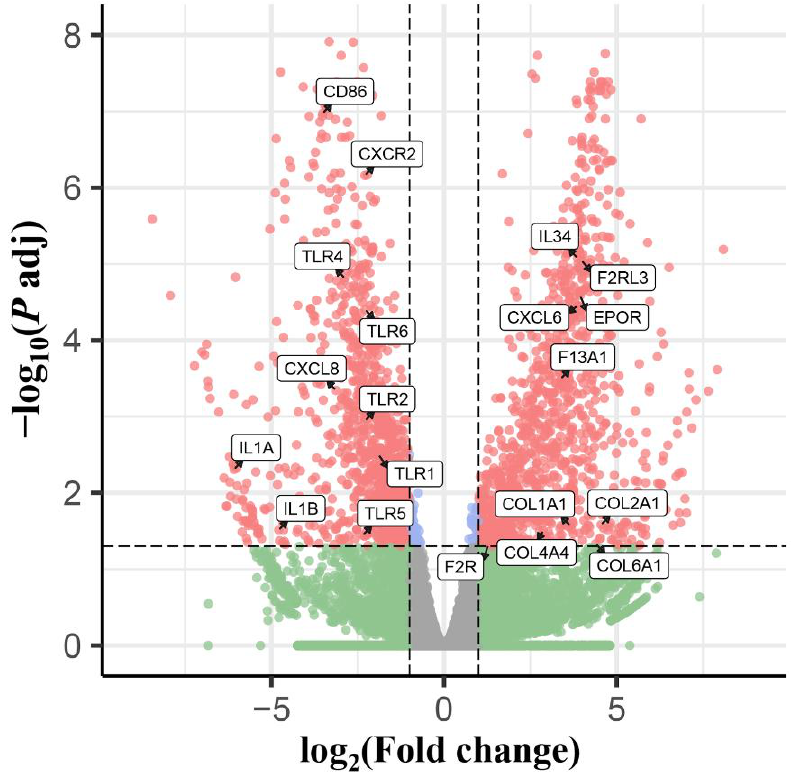
Figure 1. The volcano plots showing the differentially expressed transcripts identified from the PBMCs of puppies at 96 h after infection with 300 Toxocara canis eggs (padj < 0.05 and |log 2 (Fold- Change)| > 1).